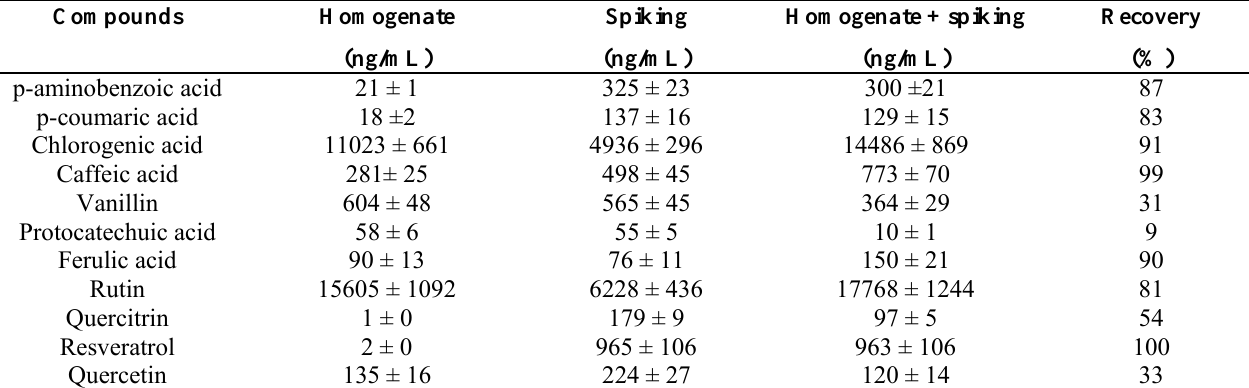
Table 6. Sonication at 22 °C, 50% efficiency.